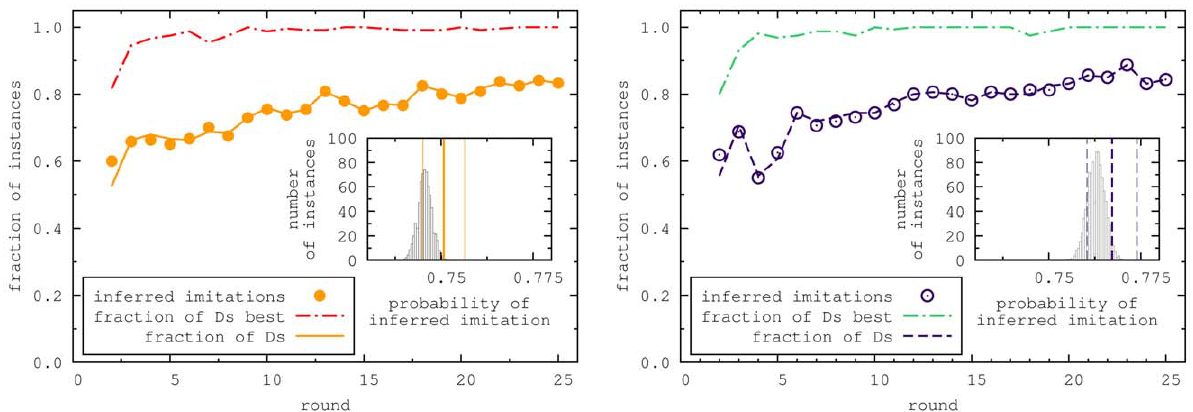
Figure 2. Unconditional imitation test in the spatial treatment (left) and in the non spatial treatment (right). The main panels show three different type of data: the fraction of inferred imitations, the level of defection and fraction of decisions in which defection was the best performing strategy in the neighborhood. The inferred level of imitation is the fraction of actions in which the players action coincided with the action of the best neighbor in the previous round. Since defection is almost always the best performing strategy, a defecting player seems to be imitating. Therefore, the level of defection is almost identical to the level of the inferred imitations. However, the randomization test illustrated in the inset shows that there is still more imitation than expected in a random setting. The vertical lines show the inferred imitation observed in the experiments, plus and minus a standard deviation, and the gray bars show the distribution of the inferred imitation in the randomized sample.